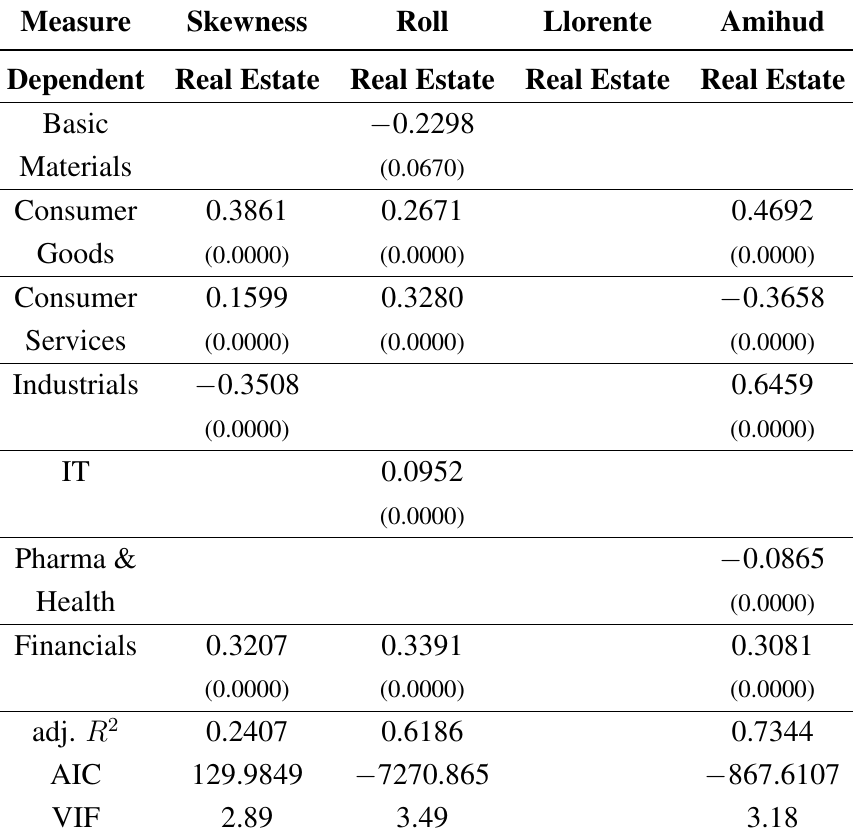
Table 4. Regressions, industry level.